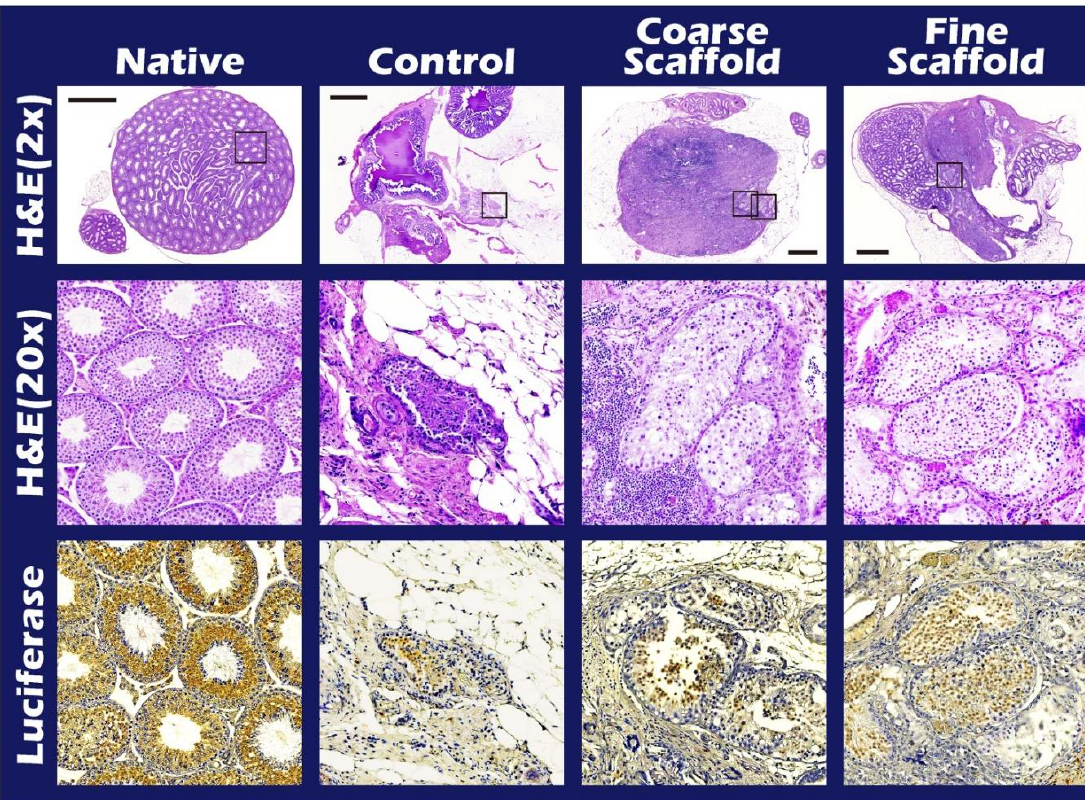
Figure 6. Representative images of testicular tissue with/without PLLA mats after preliminary HE and immunohistochemical (IHC) staining. The HE stain shows the existence of spermatogenesis in the order of the fine electrospun PLLA mat group (row 2), coarse electrospun PLLA mat group (row 2), and the control group (row 2) after long-term engraftment of the donor mature testicular tissue. The IHC stain correctly showed the testicular tissue of the FVB/N-Tg ( PolII-luc ) Ltc transgenic donor in four groups (row 3). The HE images in the first and second row from 2 × to 20 × and the IHC image in the third row of the box.